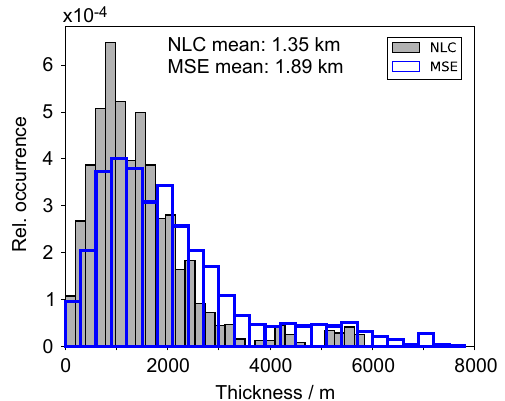
and z up ). NLC MSE